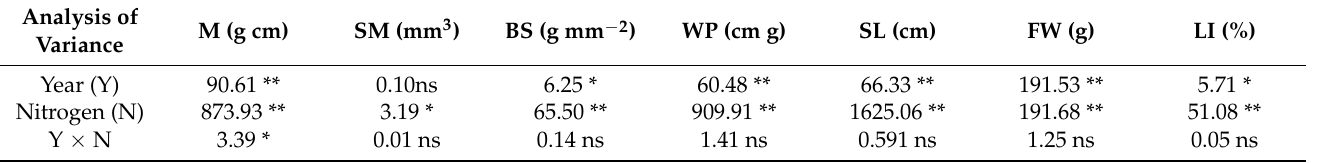
Figure 1. Relationship between M, WP and LI by whole plant of rice under dry cultivation under different N application rates in 2019 and 2020. Dotted lines indicate the LI. N0, N1, N2, N3, N4 and N5 refer to the N application rate being 0, 70, 140, 210, 280 and 350 kg ha − 1 , respectively. M: Breaking strength. WP: Bending moment of the whole plant. LI: lodging index. Table 1. Analysis of variance of LI and its related physical parameters in 2019 and